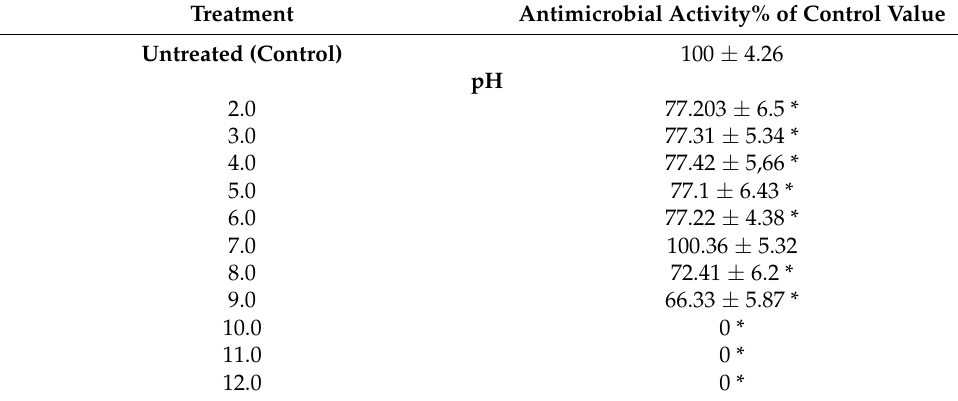
Table 4. Effects of pH and temperature on the antimicrobial activity.